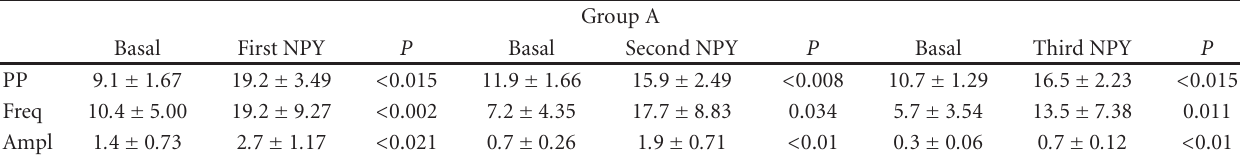
Table 1: PP: Perfusion Pressure (mmHg); Freq: Frequency of oscillations (number oscillations/min); Ampl: Amplitude of oscillations (mm Hg); NPY = Neuropeptide Y.